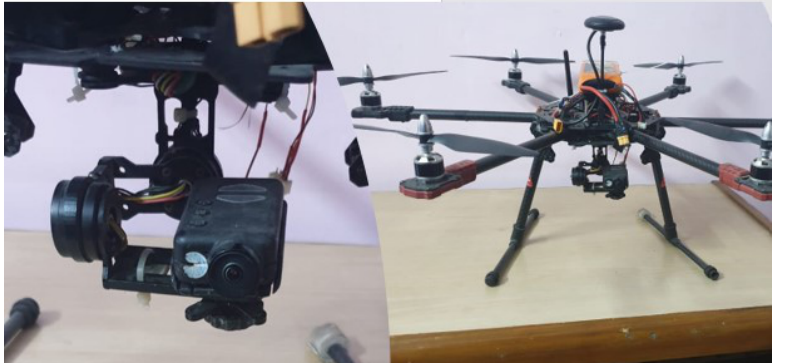
Figure 2. UAV system architecture.